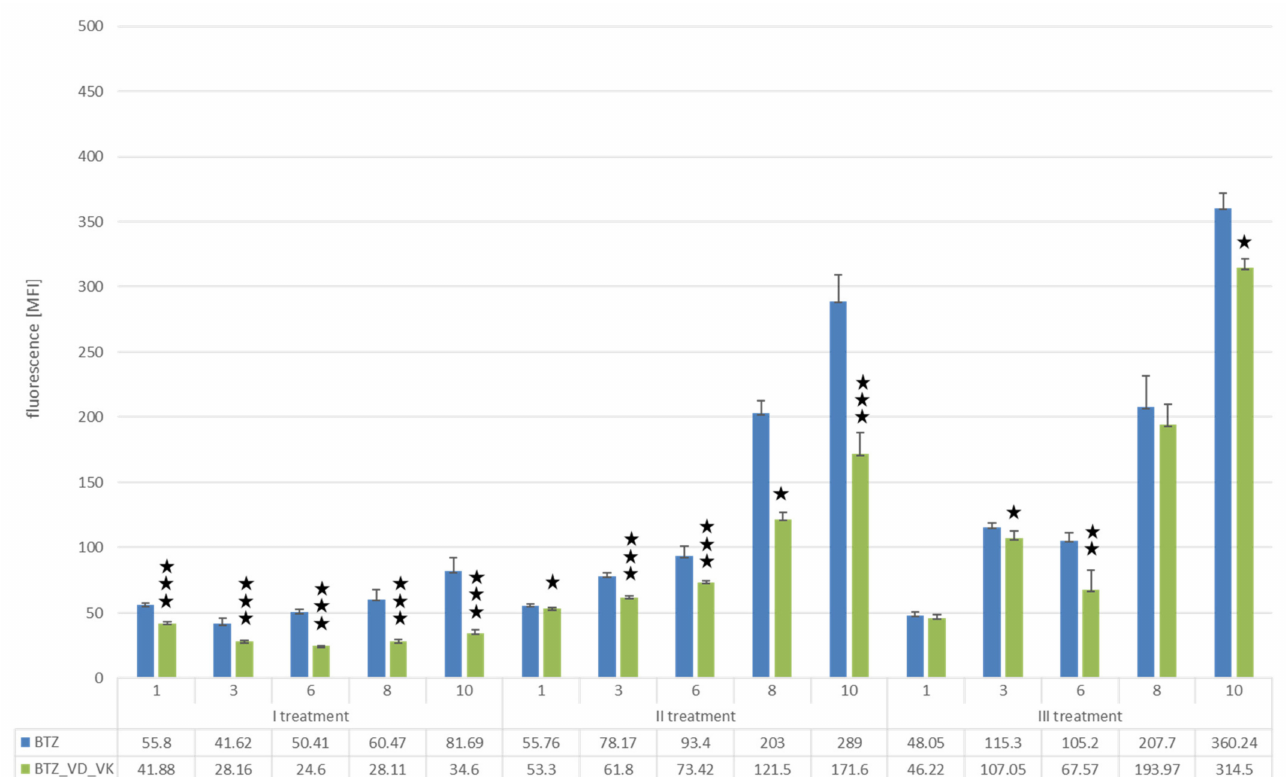
Figure 5. Analysis of U266 cell proliferation using the Alamar blue assay. The diagram shows the results after each BTZ treatment with simultaneous VD and VK incubation or BTZ alone (control). Measurements were performed on days 1, 3, 6, 8 and 10 after treatment with the agents. Student’s t -test; *** p < 0.000001; ** p < 0.0001; * p <